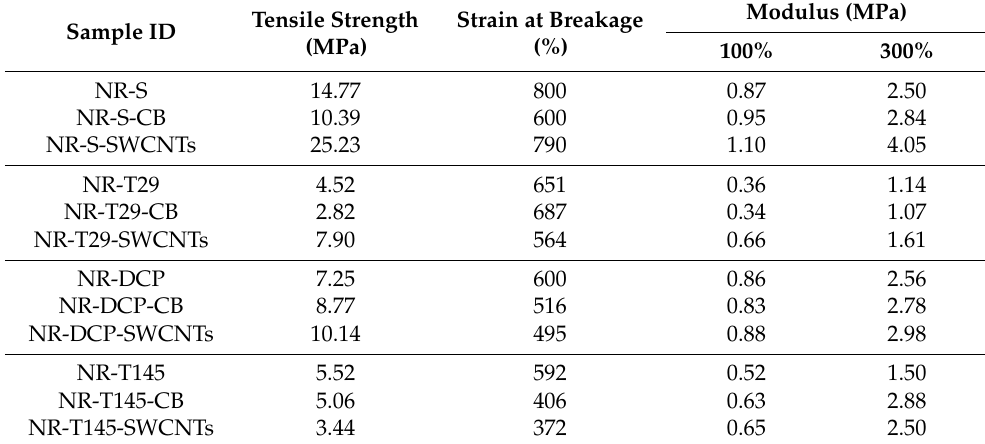
Table 5. Values of tensile properties obtained for NR composites.